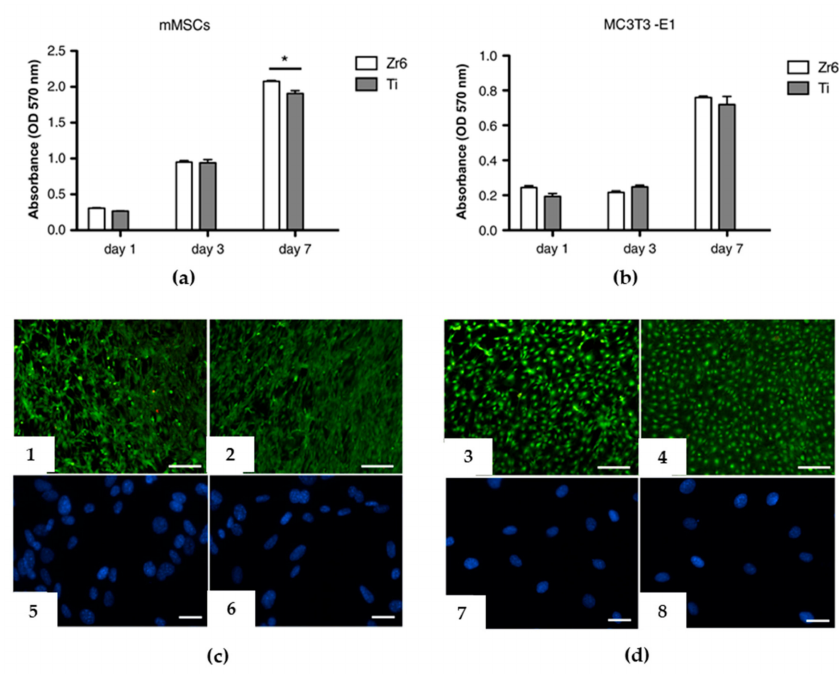
Figure 4. Analysis of mesenchymal stem cell (MSC) ( a ) and MC3T3-E1 ( b ) cell proliferations by MTT assay after 1, 3, and 7 days of seeding on samples; * p ≤ 0.01; n = 3. Analysis of cell viability was carried out through live / dead assay ( c , d ); calcein AM stains for live cells in green; EthD-1 stains for dead cells in red: (1) and (2) show MSCs; (3) and (4) show MC3T3-E1 seeded on coated and uncoated samples, respectively, after 3 days. Nuclear shape of MSCs (5,6) and MC3T3-E1 (7,8) on coated (5,7) and uncoated (6,8) samples. Zr6 = coated samples; Ti = uncoated samples. Scale bars: 200 µ m (1–4), 25 µ m (5–8) [45]. Reprinted with permission from [45]. © 2016 Springer